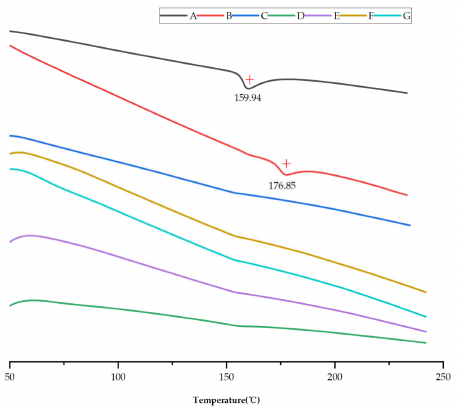
Figure 3. DSC curves of NIT ( A ), NIT PM ( B ), Soluplus ® ( C ), NIT AM (( D ), 200 × ), saSMSD/ NIT NC CP ( E ), saSMSD/ NIT NC FQC ( F ), saSMSD/ NIT C HME ( G